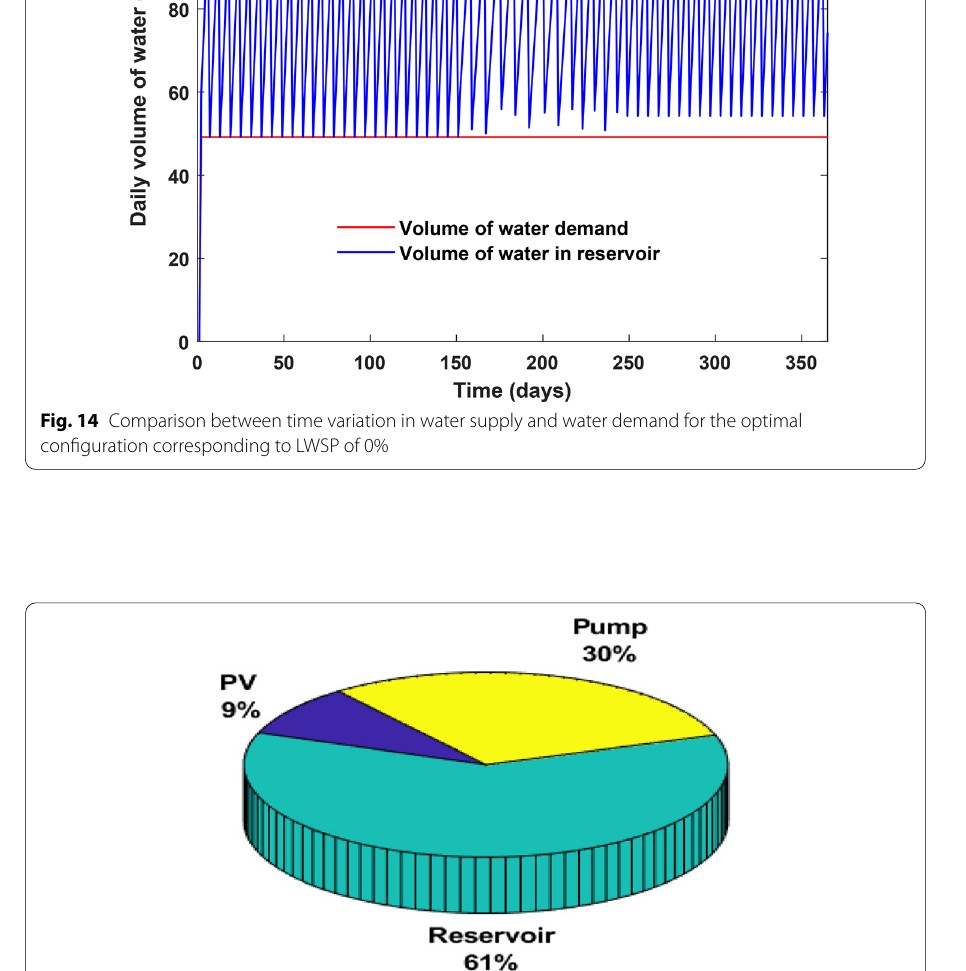
Fig. 15 Contribution of each key component of the system on the total investment cost for the optimal configuration corresponding to LWSP of 0%